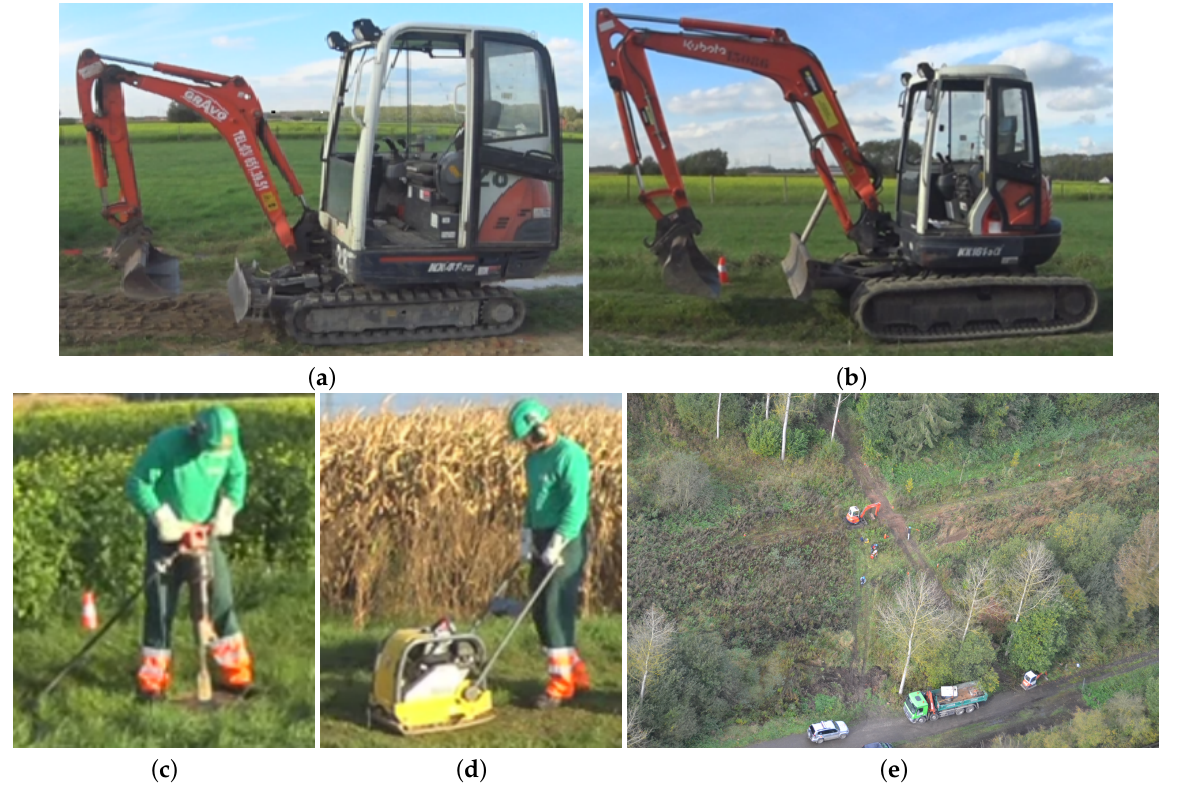
Figure 4. Database machines: ( a ) big excavator; ( b ) small excavator; ( c ) pneumatic hammer; ( d ) plate compactor; and ( e ) aerial view (figures ( a – d ) are reproduced with permission from